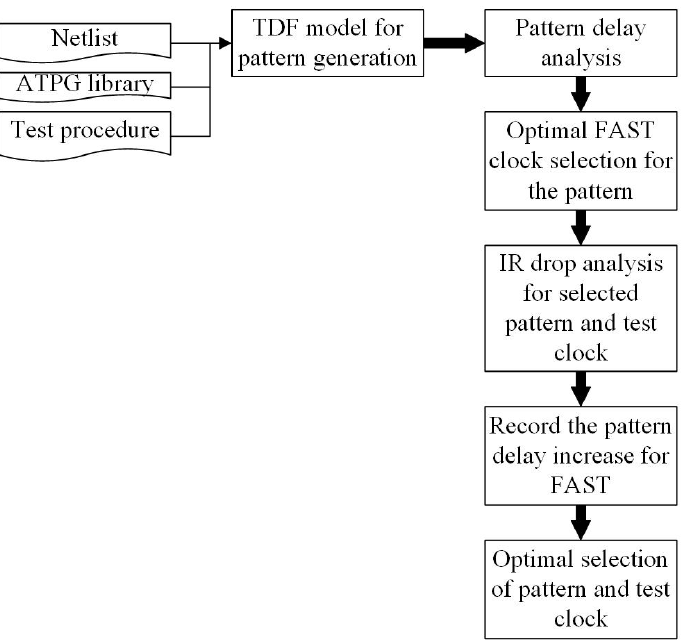
Figure 8. Generalized flow chart for FAST application in actual design